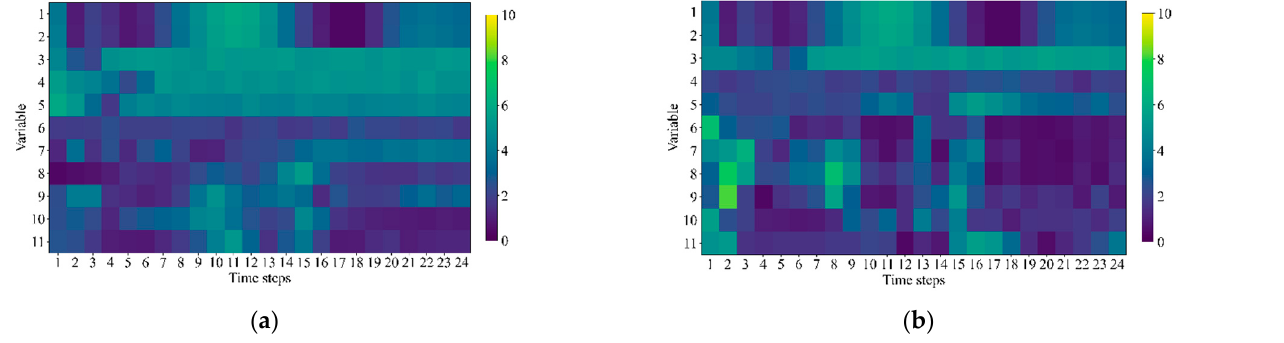
Figure 9. Distance-coded heat map of working condition 3. ( a ) Heat map of operating parameters of atmospheric two-line products. ( b ) Heat map of operating parameters of vacuum two-line prod- ucts.